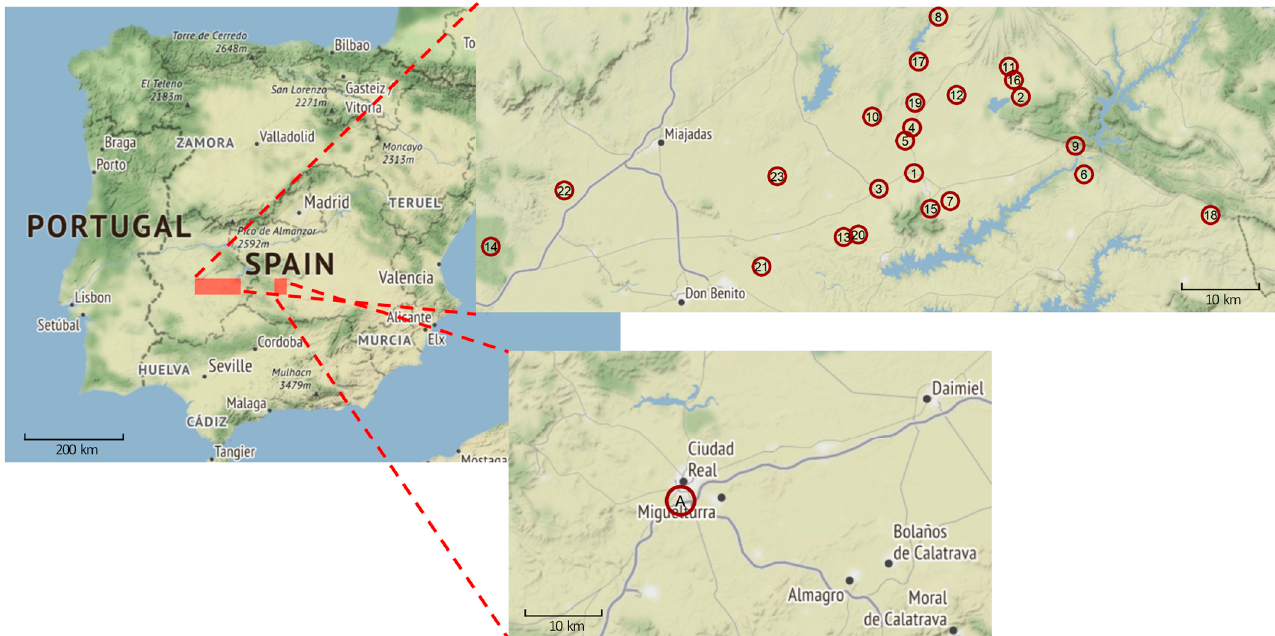
Figure 1. Outbreaks of B. anthracis in west central and central Spain from August 19 to 14 December 2021. A map of Spain is shown ( center-left image ) with close-ups of the two outbreak regions. The first outbreak took place near the city of Ciudad Real ( lower-right image ), and the second covered several villages in the Extremadura region ( upper-right image ). Red circles indicate the location of the affected farms, numbered chronologically by the start date of the outbreaks (Extremadura map) or alphabetically (Ciudad Real map). For details of these outbreaks, see Table S1. Data were extracted from the Spanish reports sent to the OIE (https://www.woah.org/). Map tiles by Stamen Design, under CC BY 3.0 license. Data from OpenStreetMap, under ODbL.